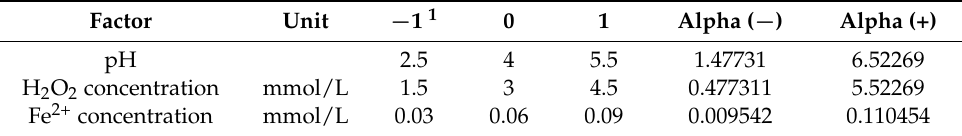
Table 1. Details of the central composite design optimization by Design Expert 8.0.5b software.